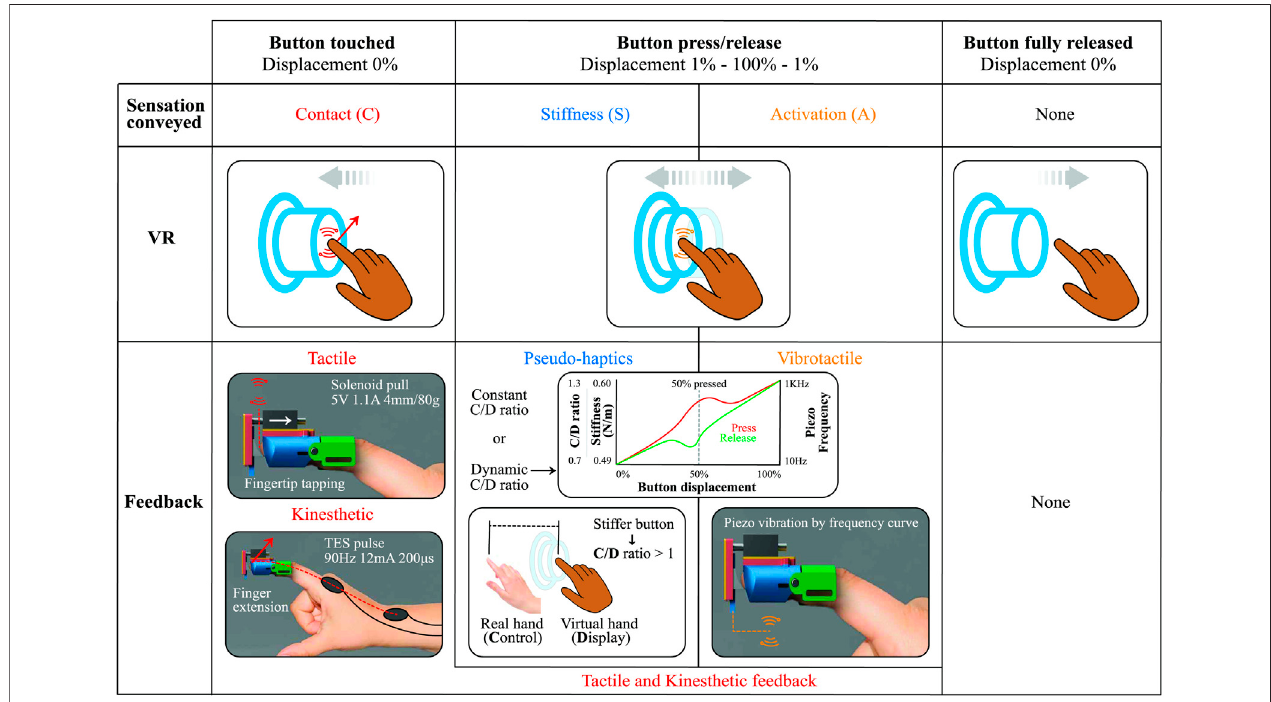
FIGURE 5 | Step by step process of approaching, pressing, and releasing a virtual button. Additionally, the corresponding technology that convey the different sensations involved in such 3DUI interactions.